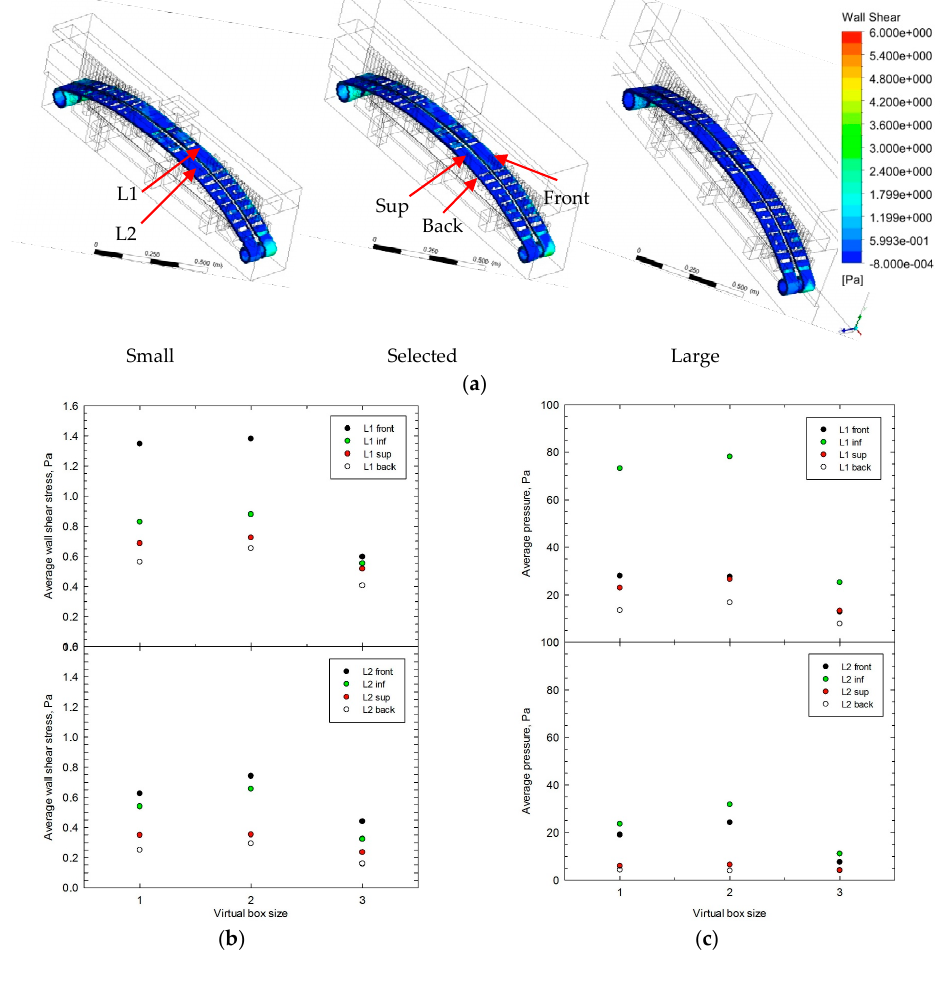
Figure 11. ( a ) Comparison of computed wall shear stress maps on the leaf spring surfaces for the first carousel position, with small, selected, and large virtual boxes. ( b ) Average wall shear stress per face for three box sizes and ( c ) average pressure per face for three box sizes. L1 = Leaf 1, L2 = Leaf 2, box size 1 = small, 2 = selected, 3 = large.